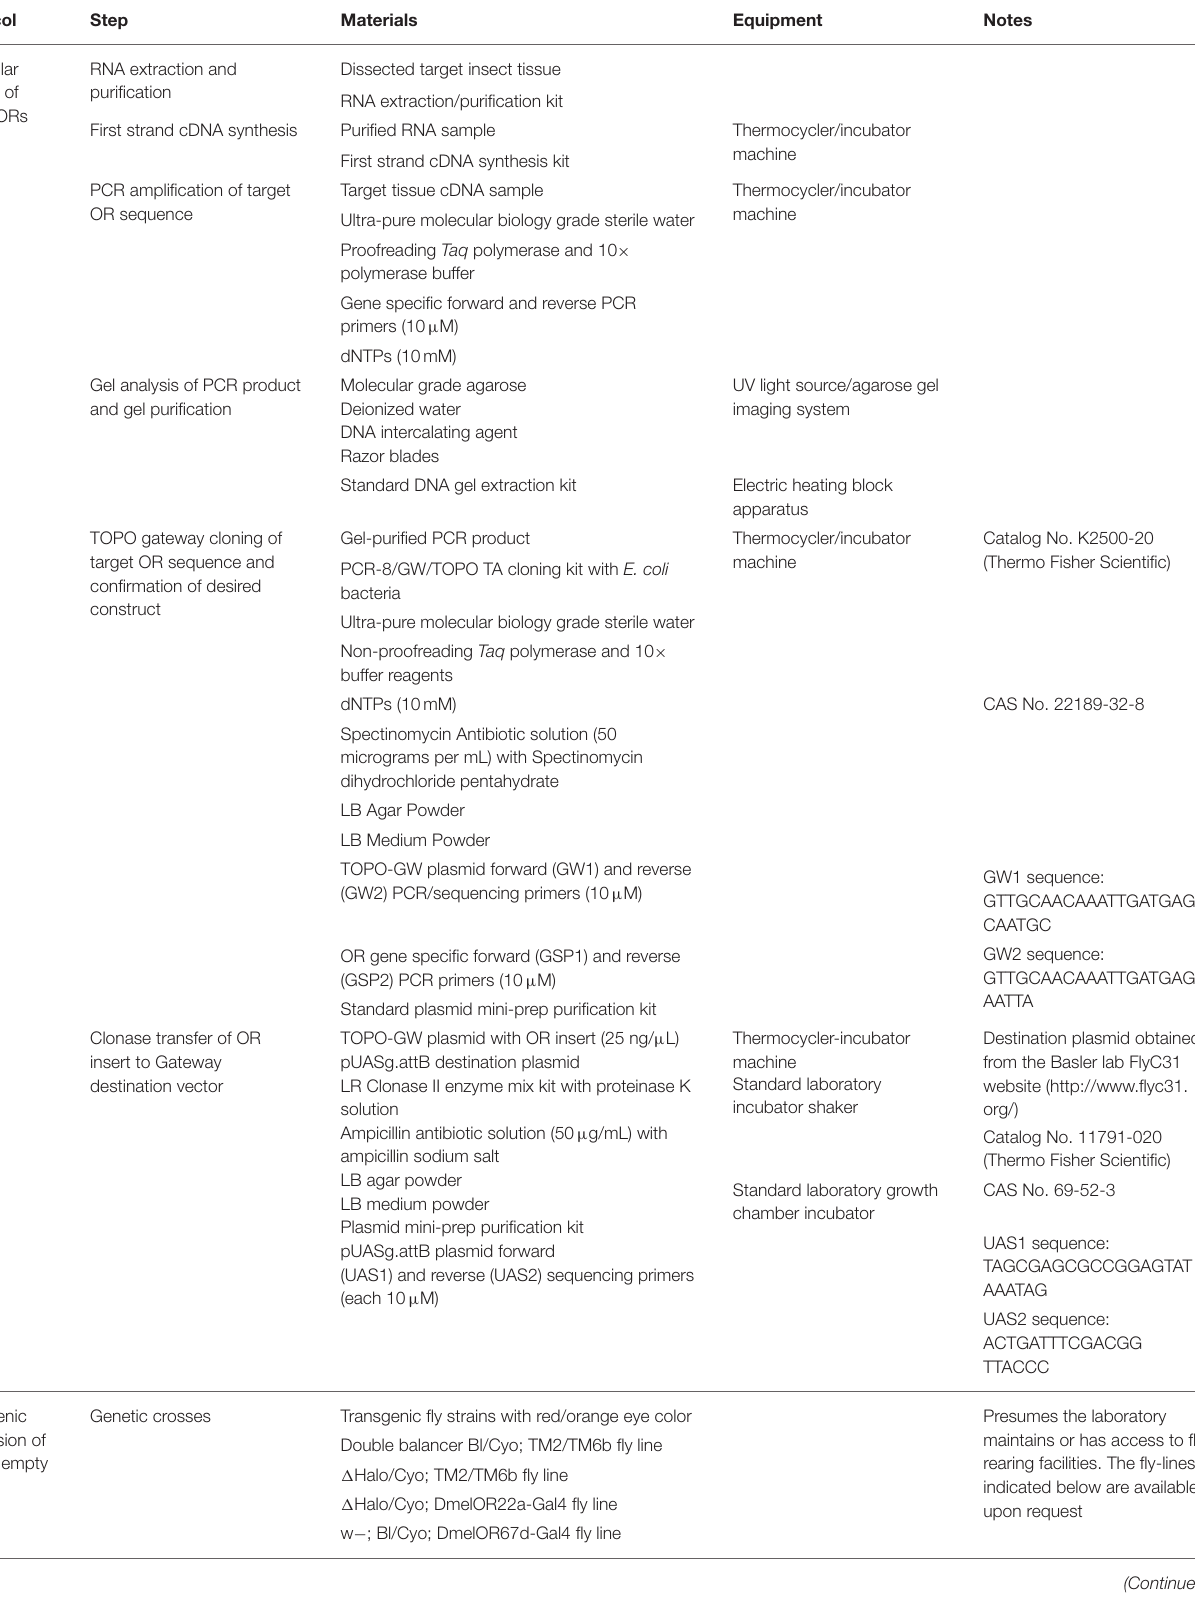
TABLE 1 | Materials and equipment.